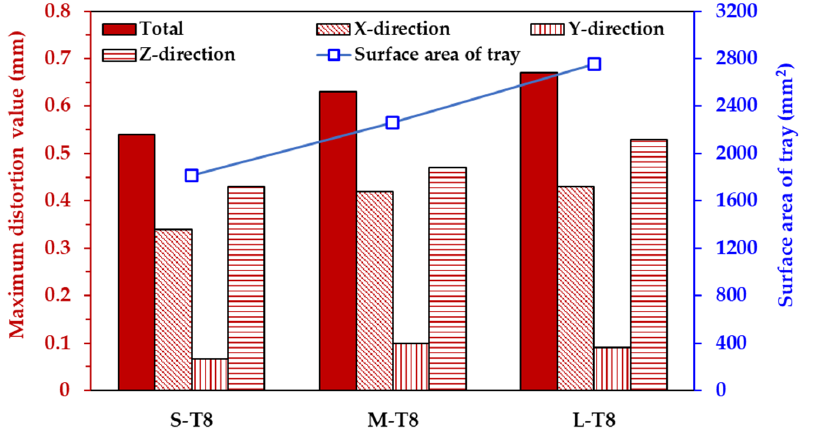
Figure 11. The maximum distortion of as-built tibial component fabricated by different sizes.